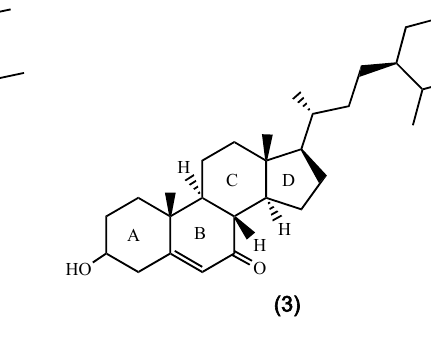
Figure 1: The structure of isolated compounds 1, 2 and 3 from D. oblongifolia .